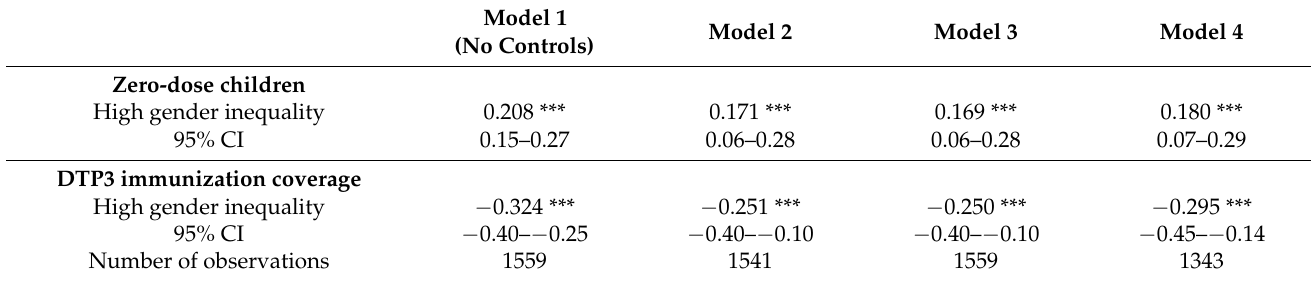
Table 4. Average marginal effects of GII on the predicted value of zero dose DTP and DTP3 immu- nization coverage, (up to 162 countries,